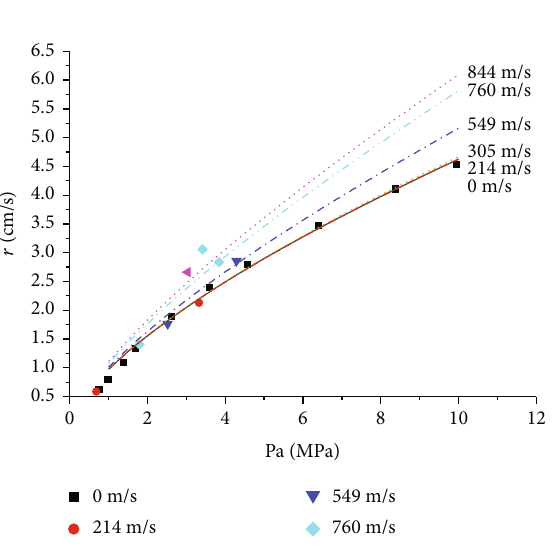
Figure 5: Propellant 5565T.